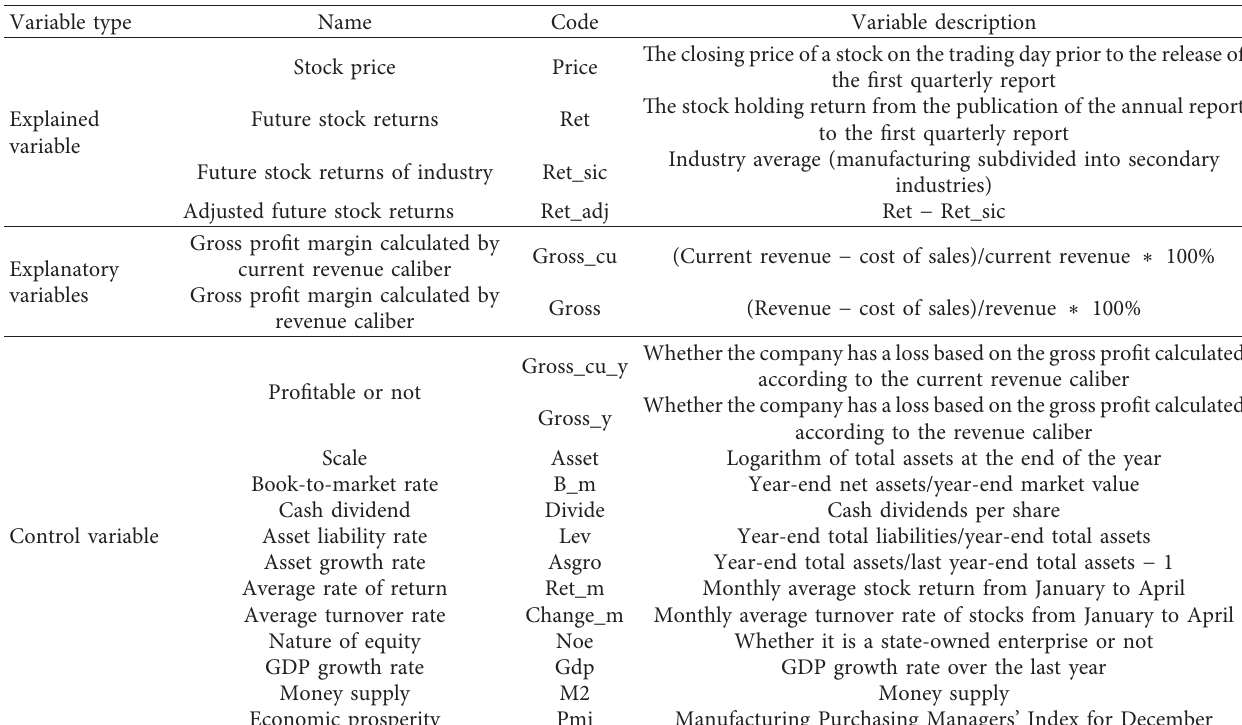
Table 1: Variable definitions.